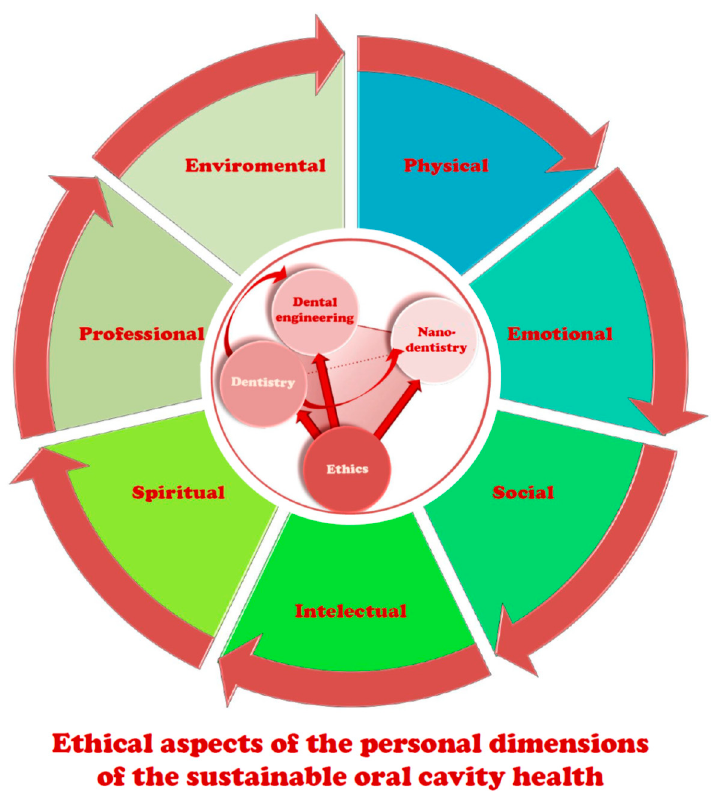
Figure 38. The scheme of the ethical aspects of the personal dimensions of sustainable oral cavity health.